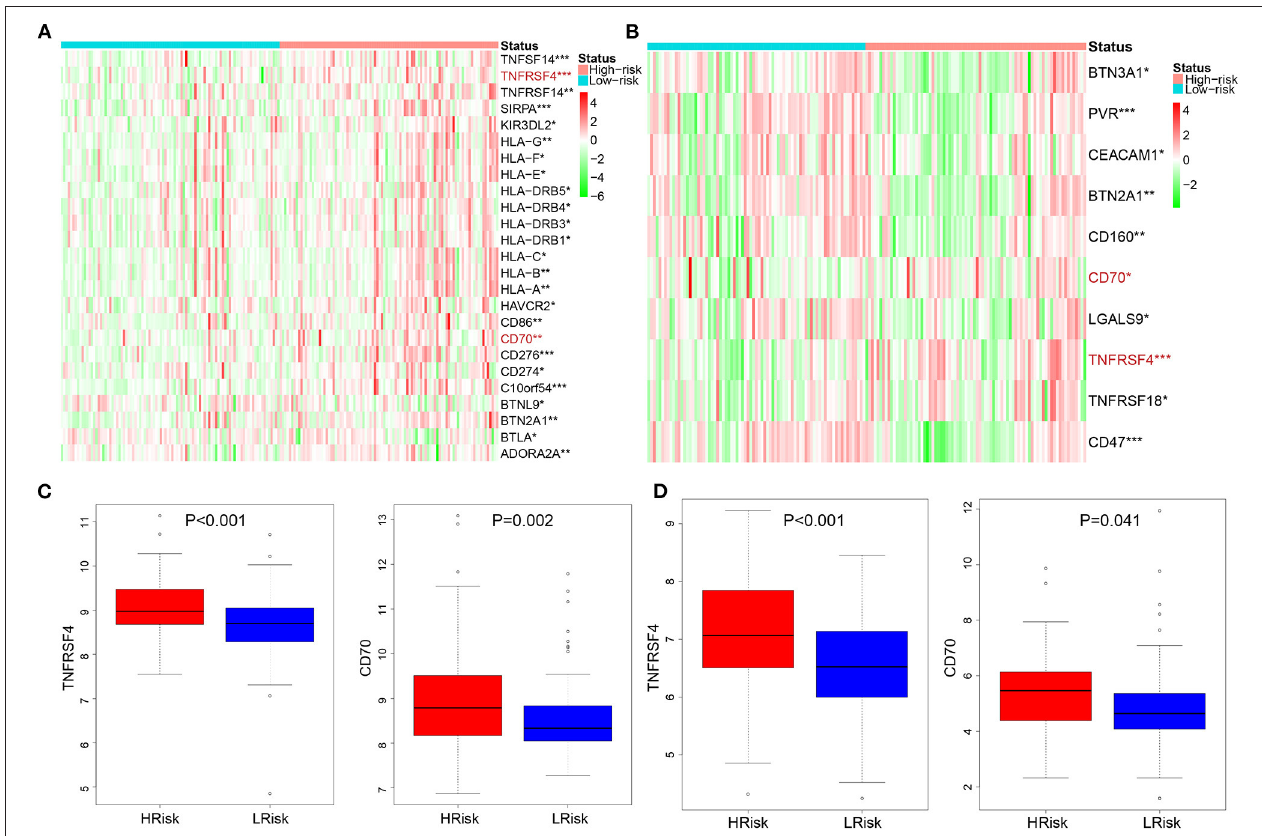
FIGURE 6 | Analysis of immune checkpoint between the HRisk and LRisk groups. Heatmap depicting the differences in immune checkpoint between the HRisk and LRisk patients in the GEO (A) and TCGA (B) cohorts. (C,D) The compassion of two representative immune checkpoints in two cohorts. HRisk, high-risk; LRisk, low-risk. * P < 0.05, ** P < 0.01, *** P <